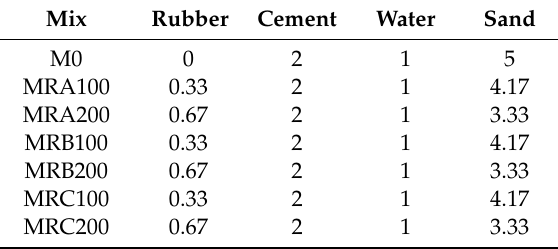
Figure 1. Particle size distribution of fine aggregates. Table 4. Mix proportions of mortars (values in mass proportion).